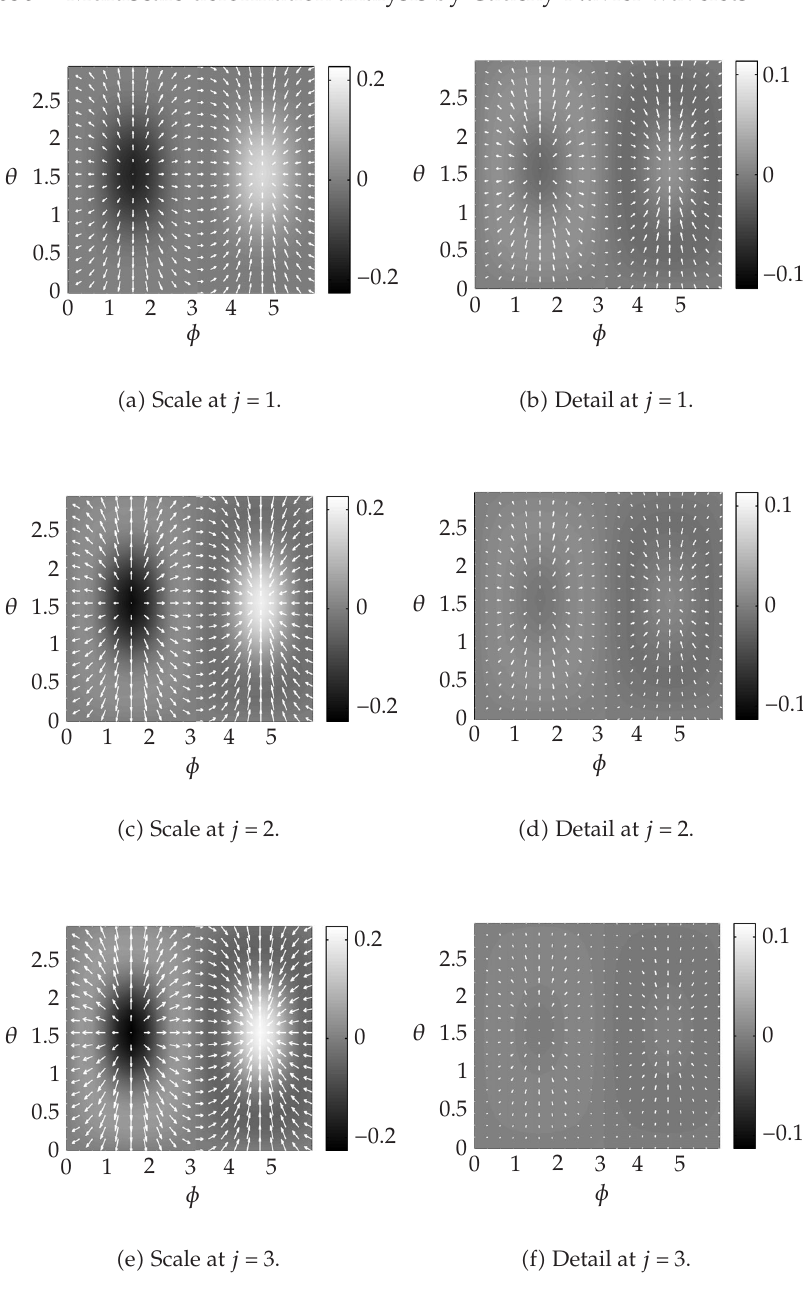
Figure 6.5 . Scale ( left ) and detail ( right ) reconstructions at levels 1, 2, and